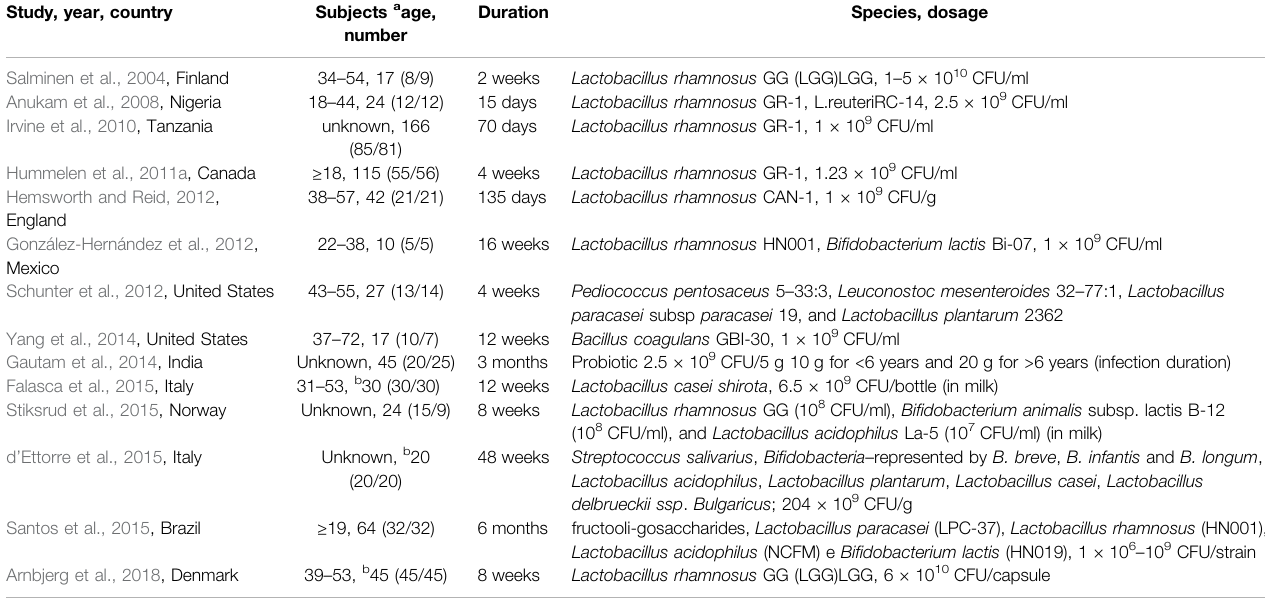
TABLE 1 | Characteristics of included studies for